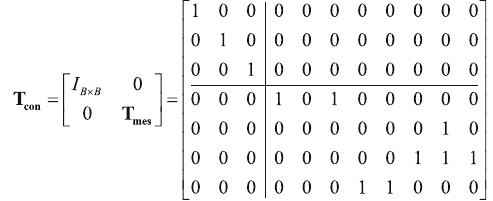
Table 5 Case study results with ZIB measurements For PMU located on Bus 2 and PDC located on Bus 9, estimation of MSCS